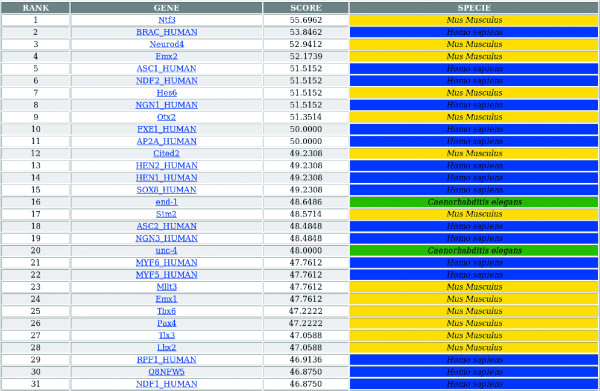
Typical output from the GO-Family program. In this figure, we have asked for all the genes from human, mouse and nematode that share more than 45% functional similarity with an input gene: the Drosophila gene engrailed. The output is composed of four columns: rank, name of similar gene, percentage of similarity and species from which the similar gene is issued.